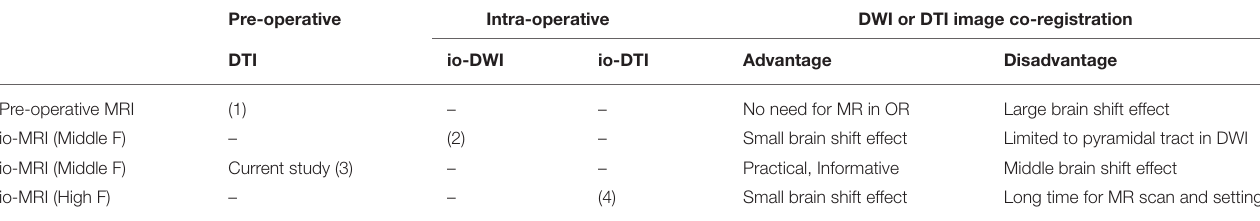
TABLE 2 | Summary of a combination of image co-registration within navigation system in